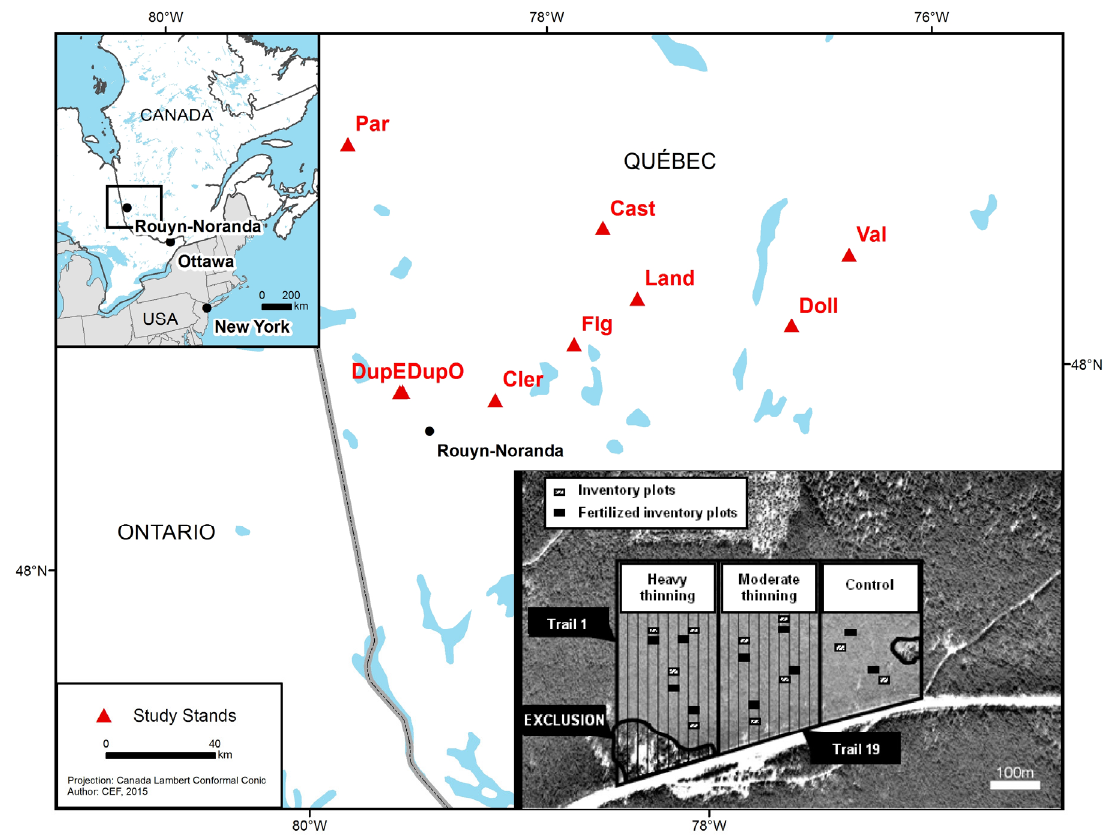
Figure 1. Location of the study stands in Northwestern Quebec (Canada) and experimental design (inset) in one stand (experimental